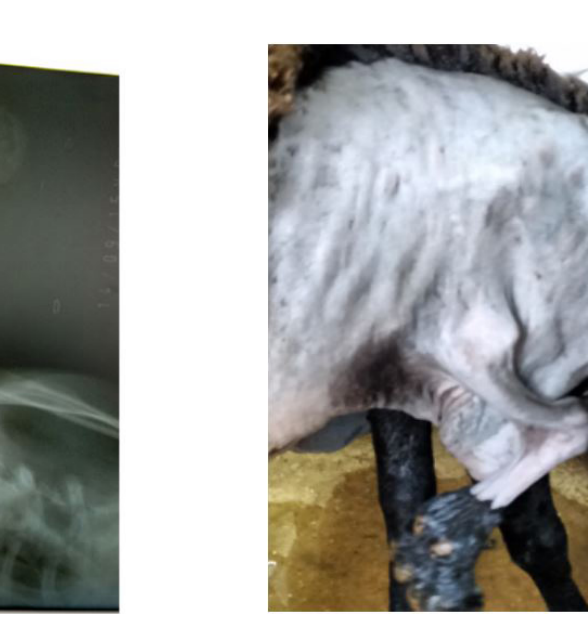
Figure 4. Radiographic image of the accessory limb attachment site (arrow).